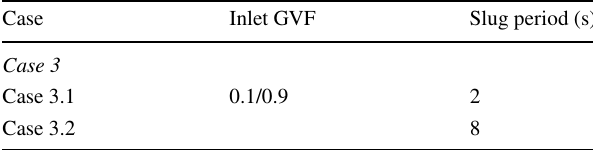
Table 4 Simulation plan for evaluation of slug handling